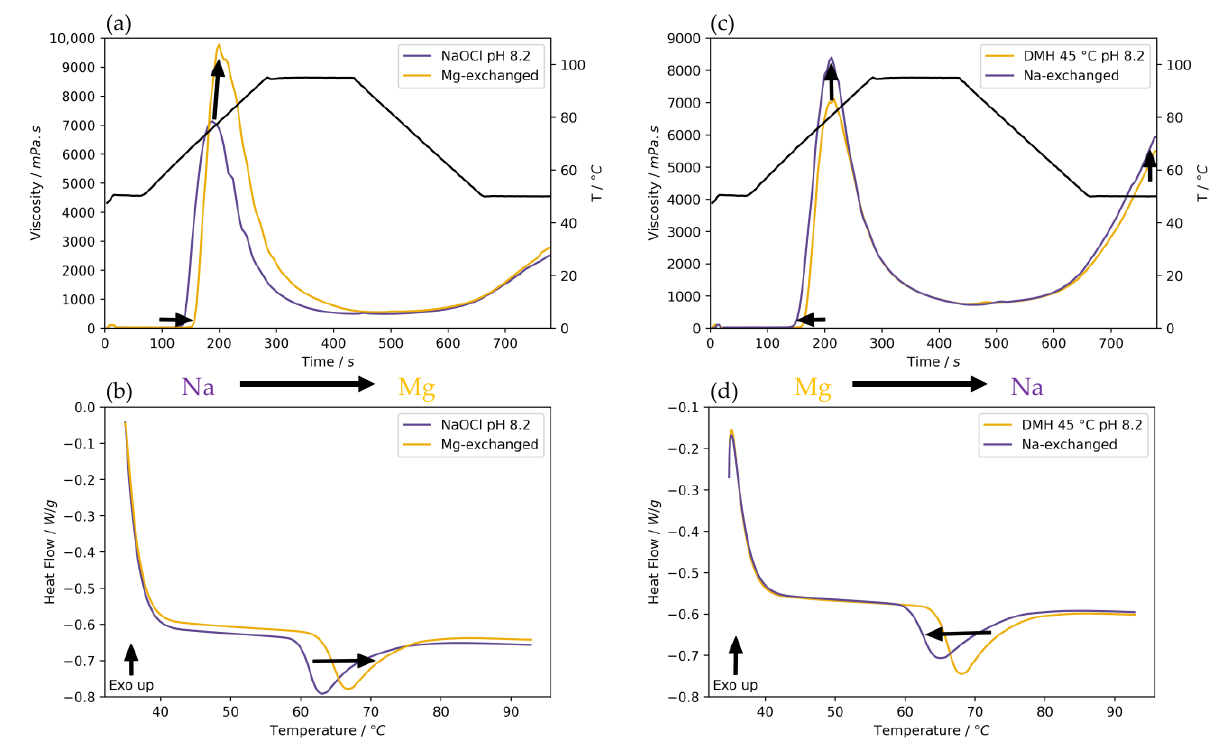
Figure 5. Result of the exchange of minerals in oxidised starch. On the left, NPS was oxidised with NaOCl at pH 8.2, at 35 °C using 5.5 mol% -OCl, followed by exchange with MgCl 2 . The samples were analysed using ( a ) RVA and ( b ) DSC. On the right, NPS was oxidised with DMH at pH 8.2, ta 45 °C using 8.5 mol% -OCl, followed by exchange with NaCl and NaOH to increase the pH. The samples were analysed using ( c ) RVA and ( d ) DSC.